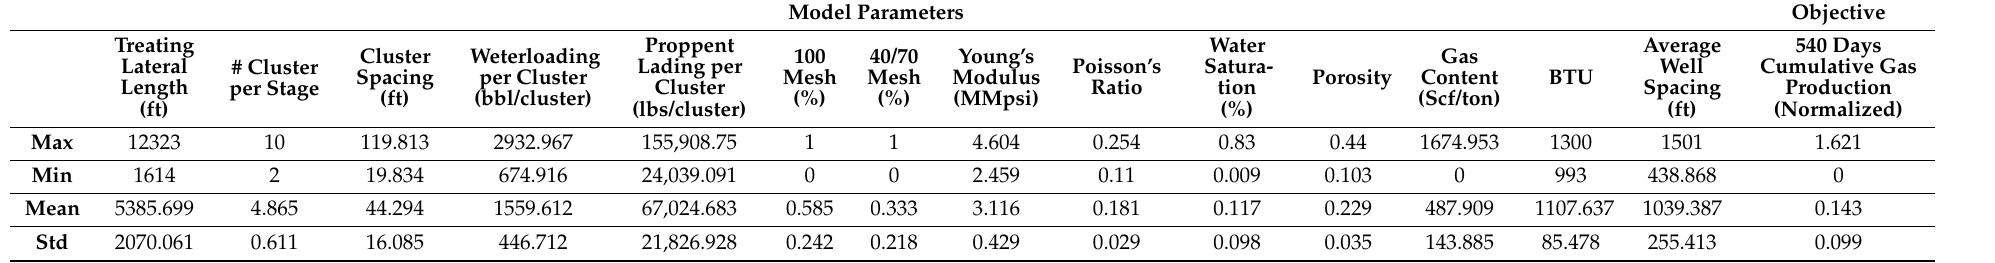
Table 5. Field completion design